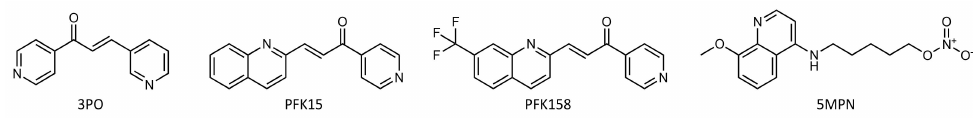
Figure 4. Chemical structure of PFKFB3 (3PO, PFK15 and PFK158) and PFKFB4 (5MPN)